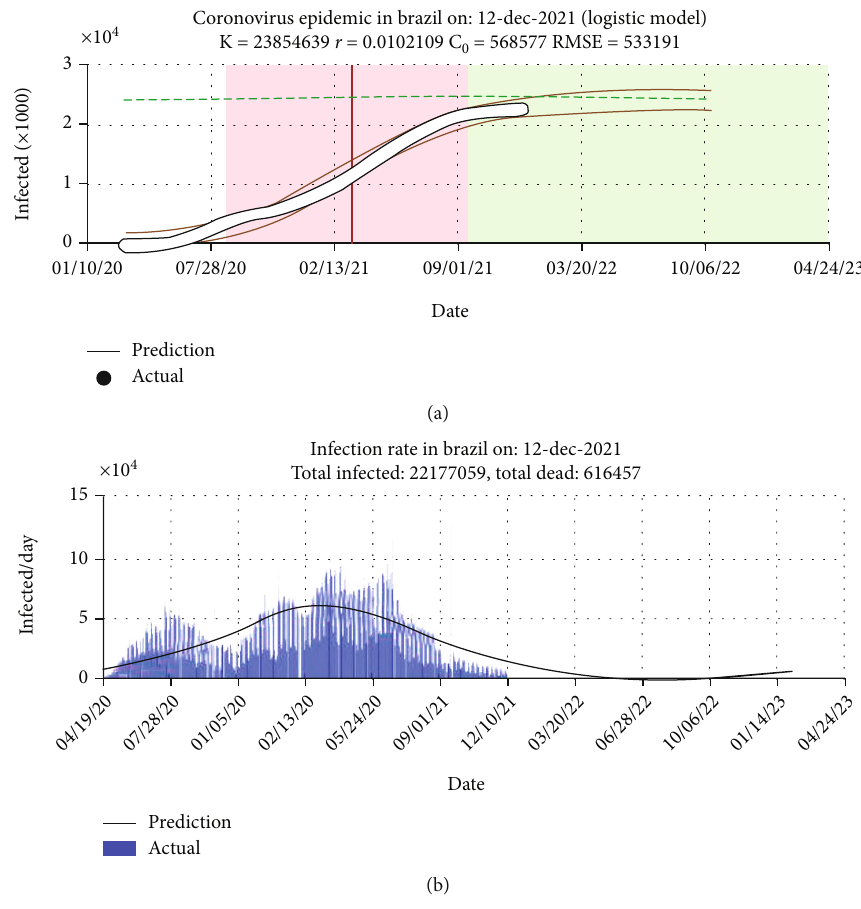
Figure 3: Performance of proposed system in Brazil: (a) prediction plot and (b) histogram error. Table 6: Short-term forecasting — proposed system in Australia. Table 7: Short-term forecasting — proposed system in